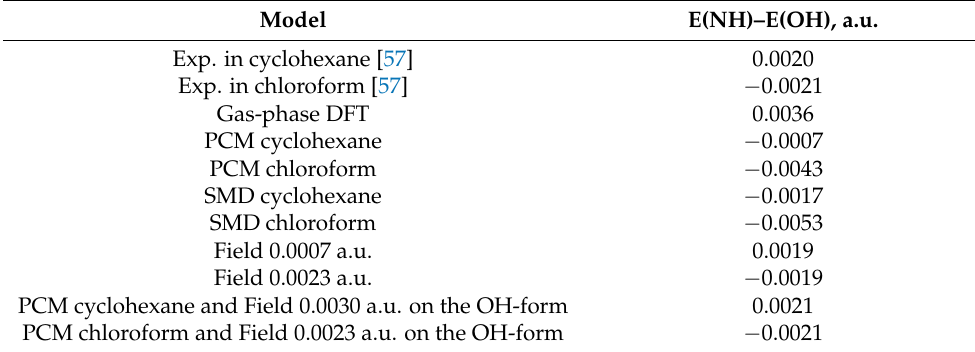
Table 1. Electronic energy differences between the NH- and OH-forms of 2,6-di-tert-butyl-4-hydroxy- pyridine—experimental values and those calculated under different